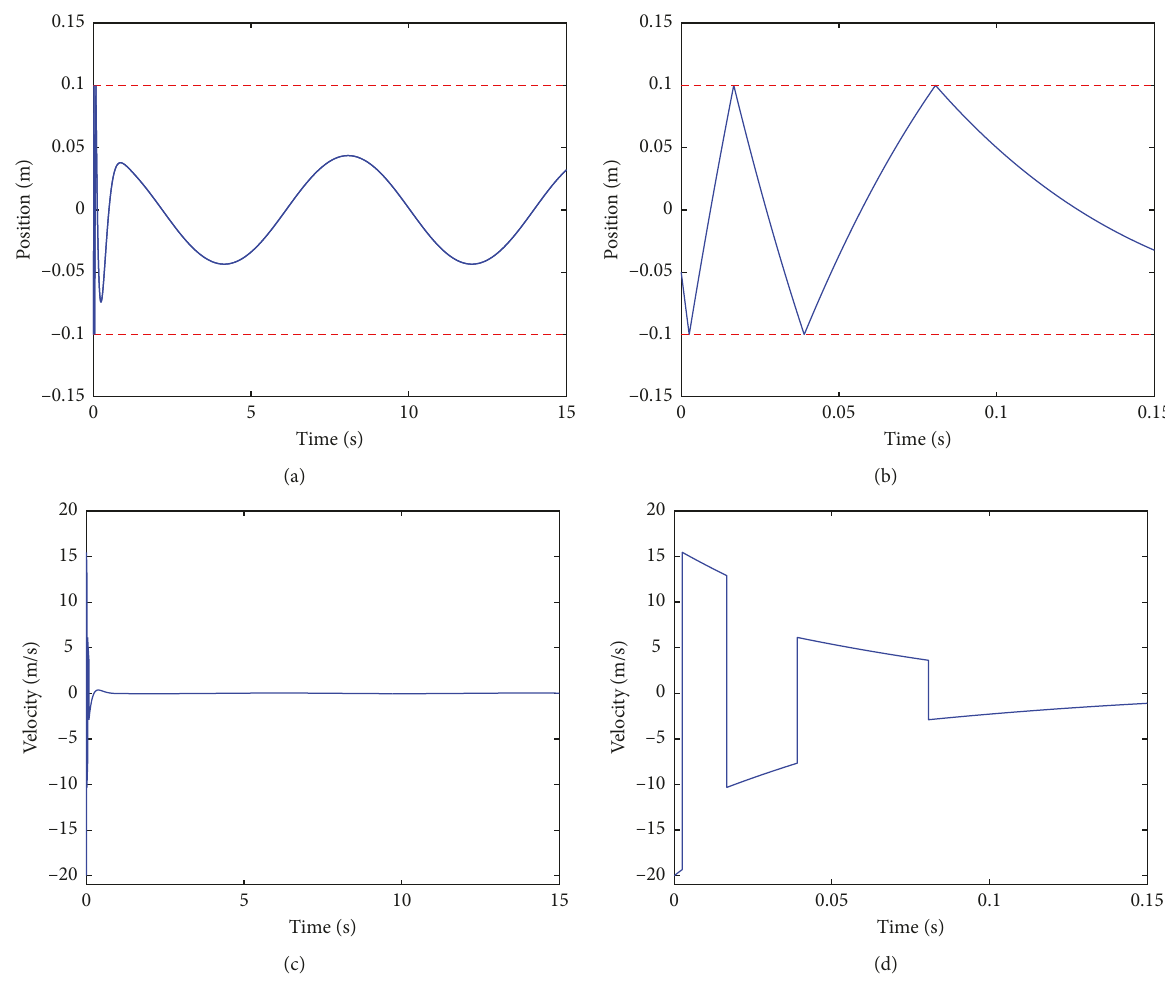
Figure 6: Simulation results of the two-sided asymmetric 1-DoF impact mechanical oscillator with d � 0 .